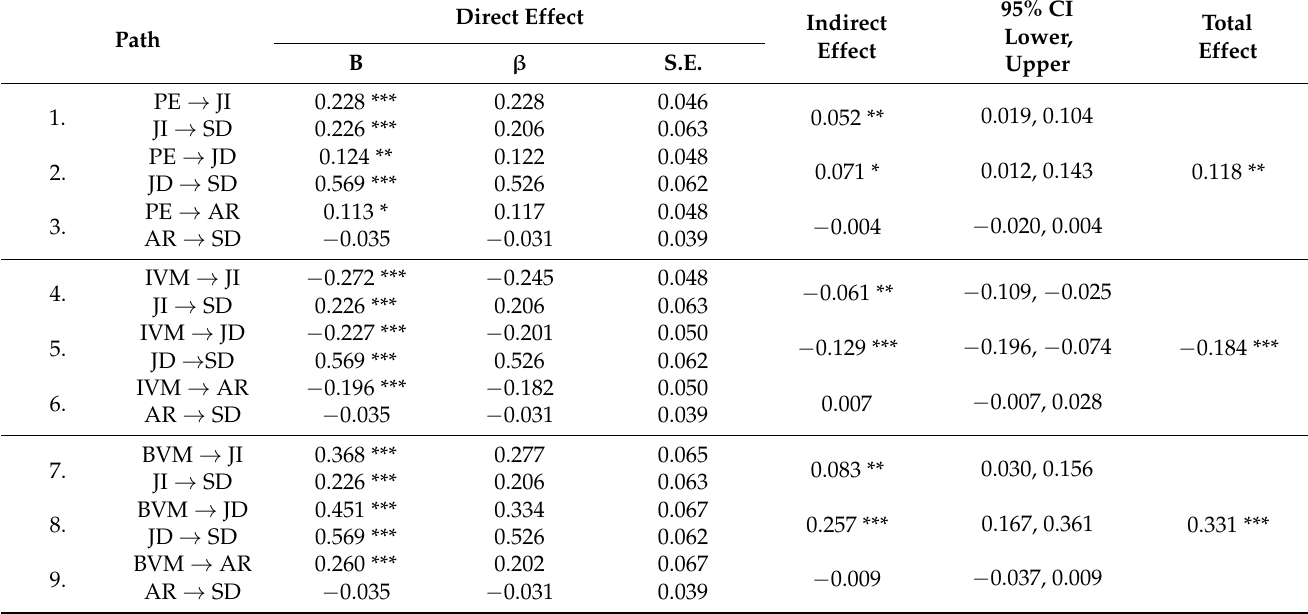
Table 5. Estimation results of the path